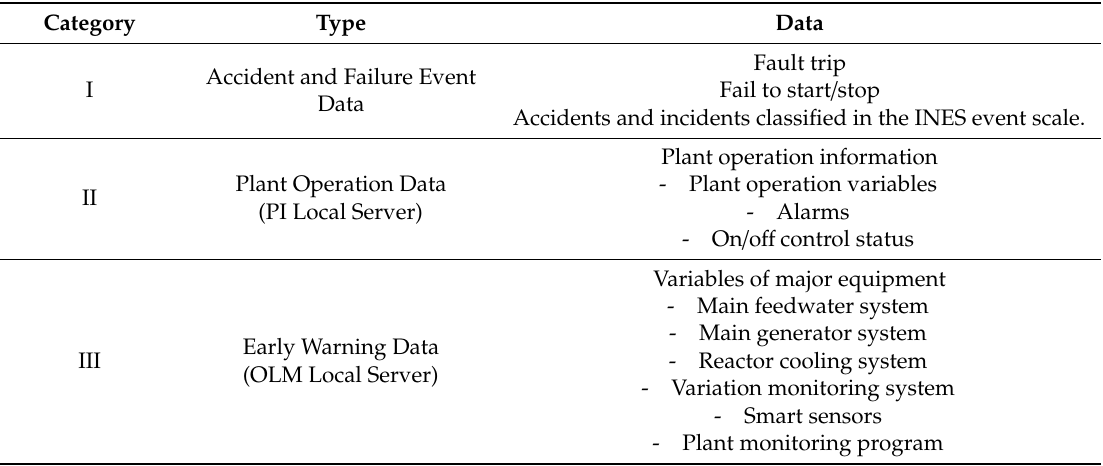
Table 1. Category of plant data.